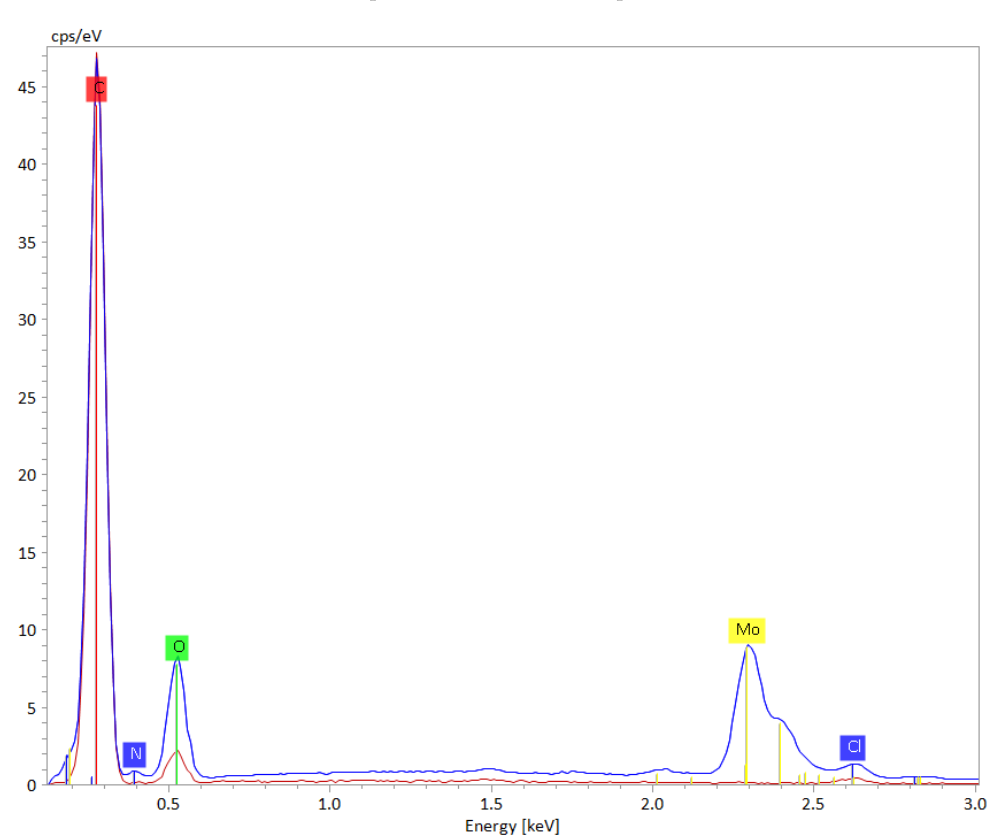
Figure 6. Intensity of EDS spectra (counts per second) vs. energy (keV) for CDC samples before (red line) and after Mo adsorption (blue line).